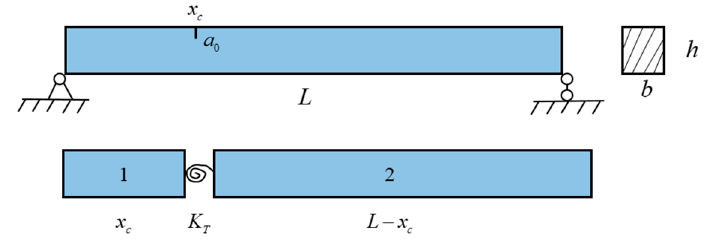
Figure 1. Model of the beam with a unilateral crack.